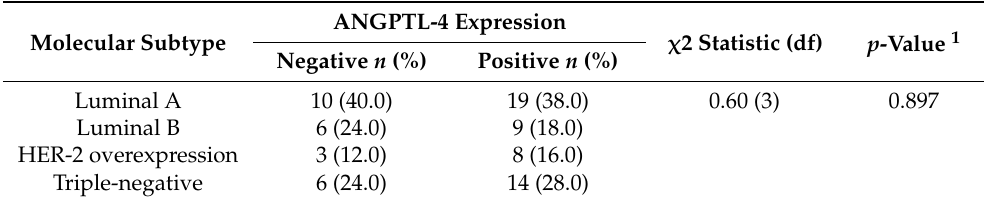
Table 4. Association of ANGPTL-4 expression with breast carcinoma molecular subtypes in young patients ( n = 75).